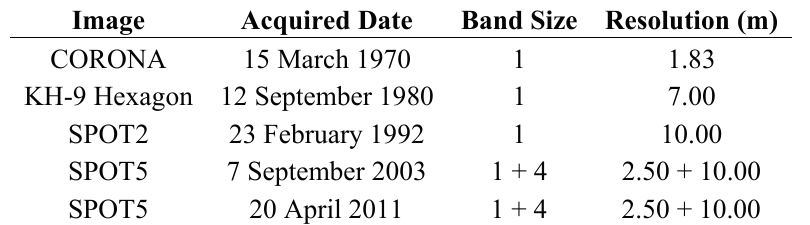
Table 2. Information about the medium–high resolution images used in this